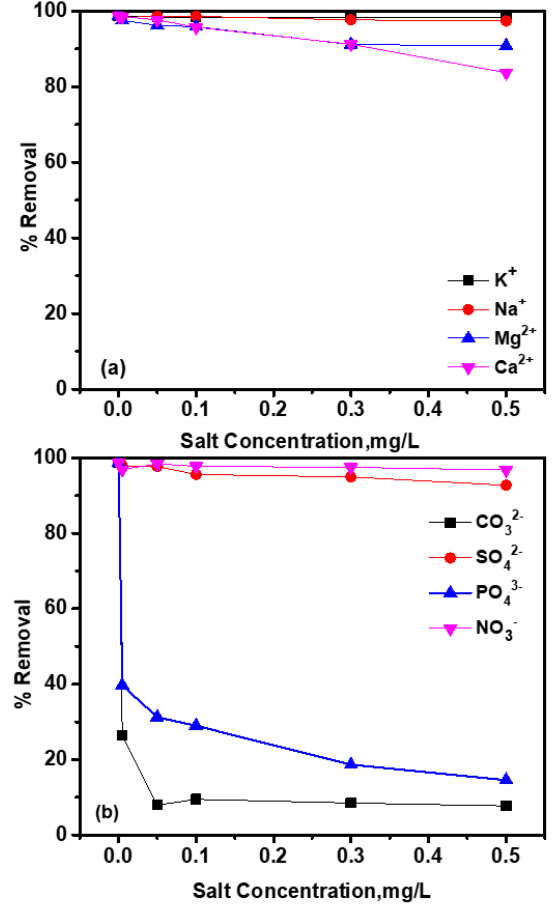
Figure 4. Co-existing ions: ( a ) cations’ and ( b ) anions’ influences on La 2 O 3 adsorptive removal of As(V) (10 mg/L) with 0.1 g/L La 2 O 3 dosage, at pH 6, and 25 °C for 60 min equilibrium.